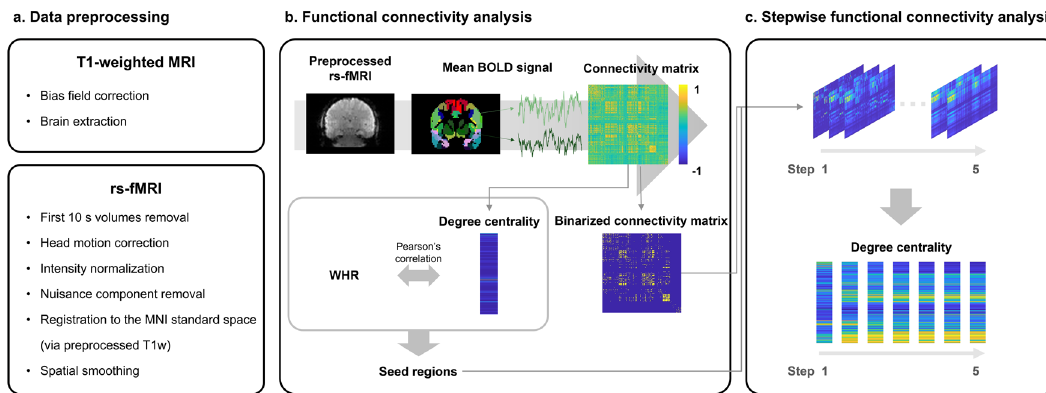
Fig. 1 Flowchart of the study. a The T1-weighted MRI and rs-fMRI data were preprocessed. b (top) We calculated partial correlations of mean time series between different brain regions de fi ned using Brainnetome atlas, (bottom) and calculated degree centrality to assess association to waist-to-hip ratio (WHR). The regions that showed signi fi cant associations were selected as seed regions for stepwise functional connectivity (SFC) analysis. c (top) The SFC analysis was performed using binarized connectivity matrix from steps one to fi ve, and (bottom) degree centrality was calculated for each step. Abbreviations: rs-fMRI resting-state functional magnetic resonance imaging, BOLD